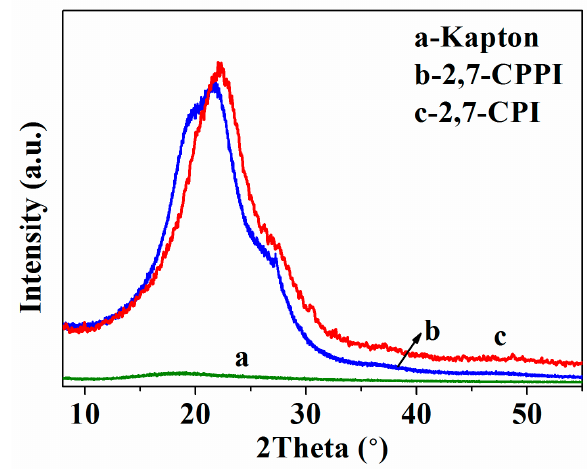
Figure 4. WAXD curve of Kapton, 2,7-CPPI and 2,7-CPI films. Table 3. Physical properties and FFV of Kapton, 2,7 ‐ CPPI and 2,7 ‐ CPI.